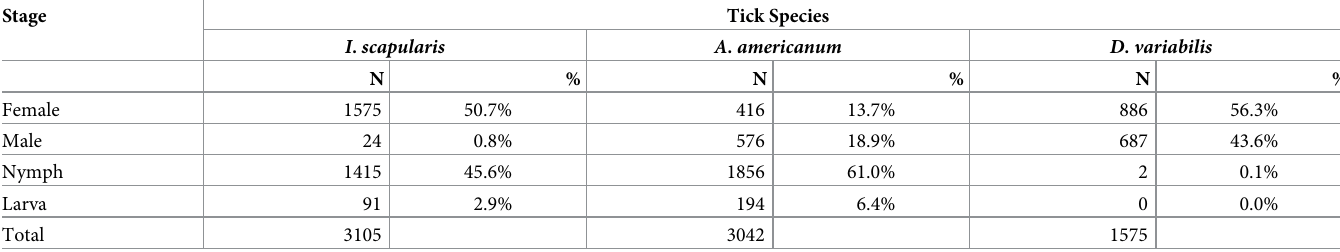
Table 1. Distribution of tick submissions by developmental stage and